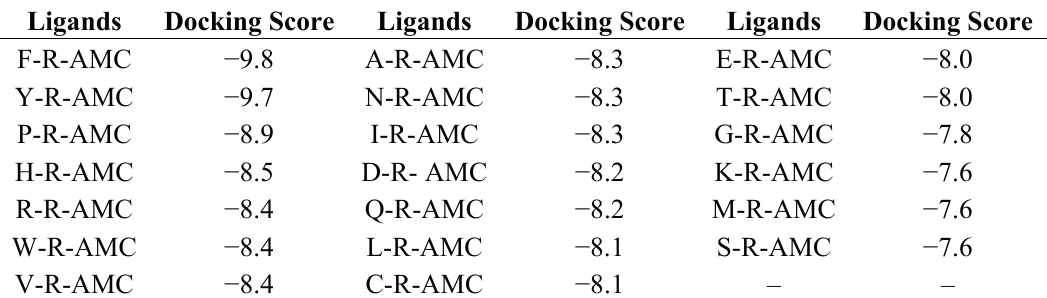
Table 3. The docking scores among the 20 dipeptides and zmCP1 (kcal·mol − 1 ). Ligands Docking Score Ligands Docking